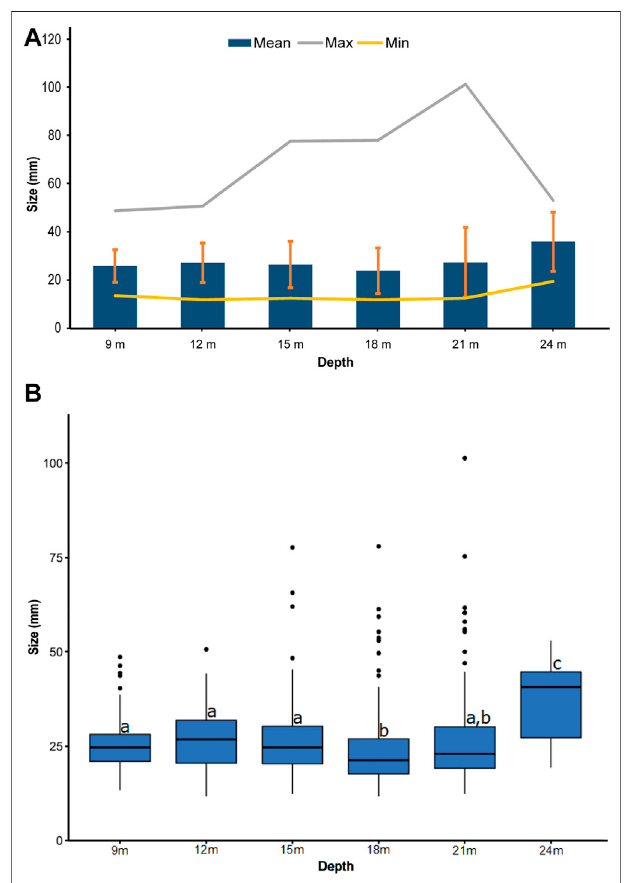
FIGURE 9 | (A) Rhodolith sizes and (B) boxplots illustrating signi fi cant differences detected across depths.